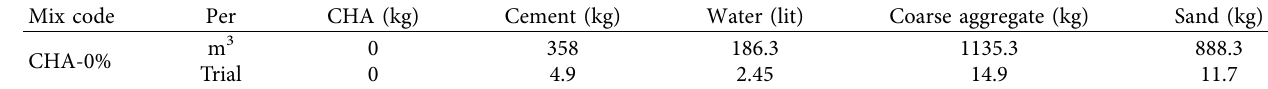
Figure 3: Grading of coarse aggregate. Table 4: Reference concrete mix proportion.